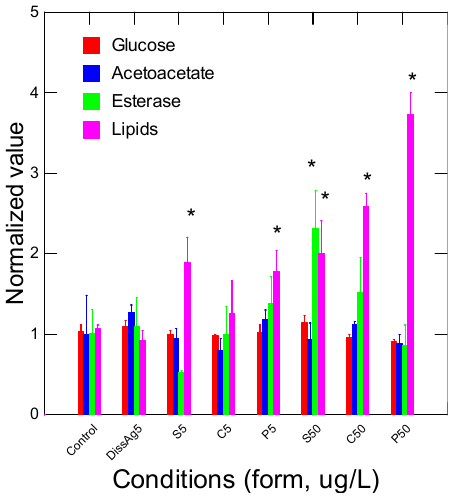
Figure 3. Energy status in trout exposed to nAg forms. Energy status was determined by following the changes in glucose, acetoacetate (a ketone body), esterases, and lipids in trout gills exposed to various forms of Ag. The data represent the mean with standard error. The star * symbol indicates significance at p ≤ 0.05 from controls.